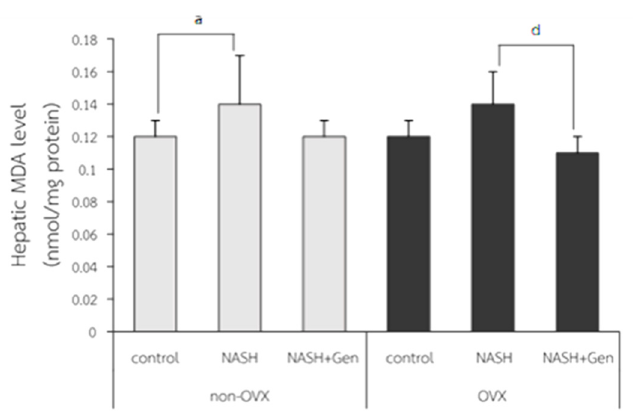
Figure 4. Malondialdehyde (MDA) level measured by TBARS assay. a: p < 0.05 comparison be- tween control and NASH groups of non-OVX rats. d: p < 0.05 comparison between NASH and NASH+Gen groups of OVX rats.